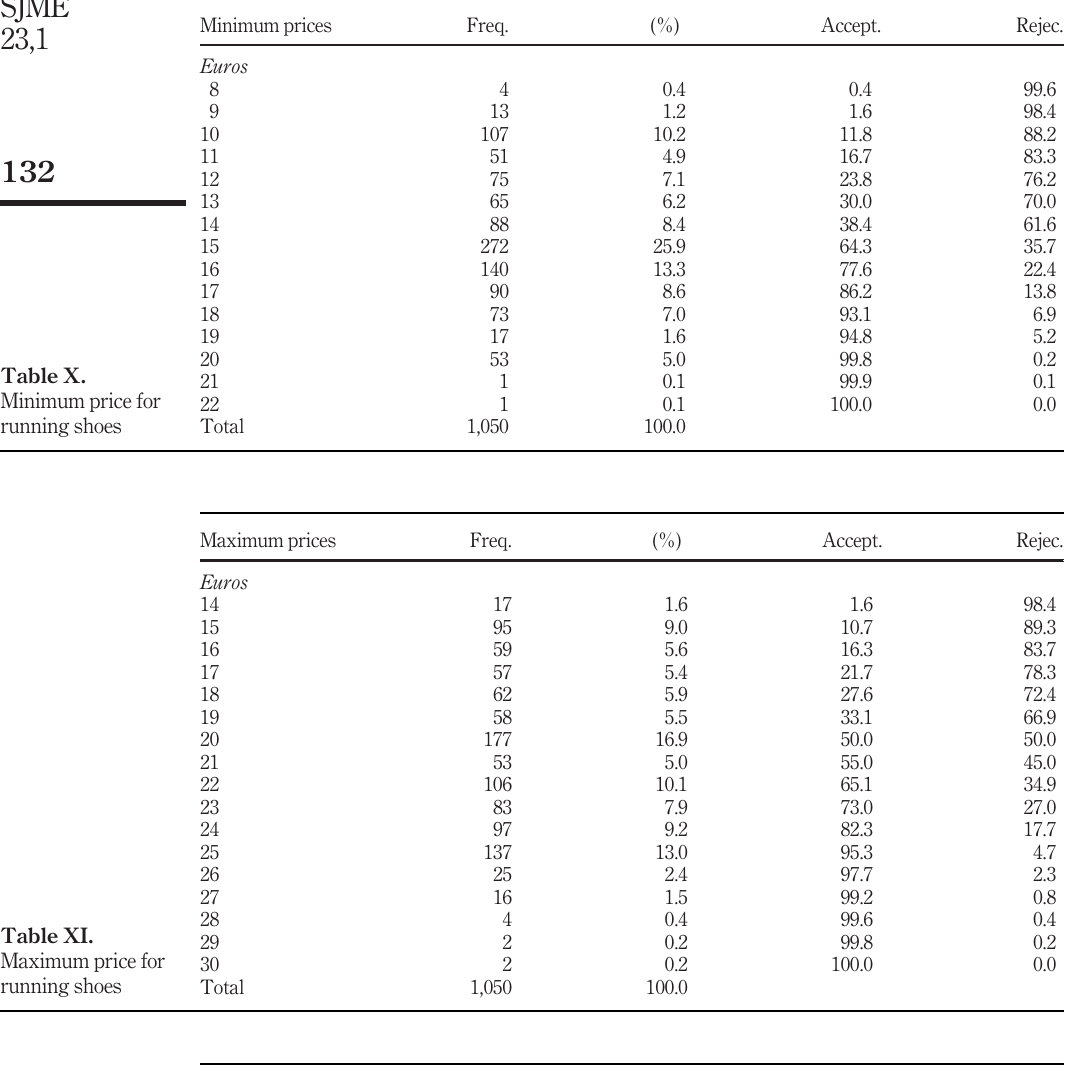
SJME Minimum prices Freq. Accept.